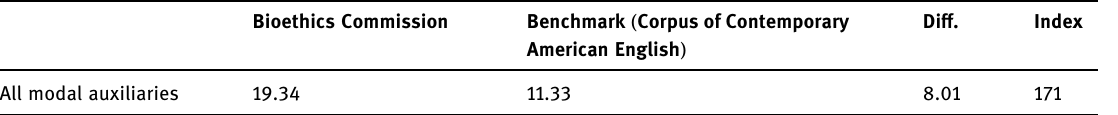
Table 1: Word list extract: frequency of all modal auxiliary verbs used per 1,000 words ( normalised, n = 1,000 ) by commission members, compared to benchmark